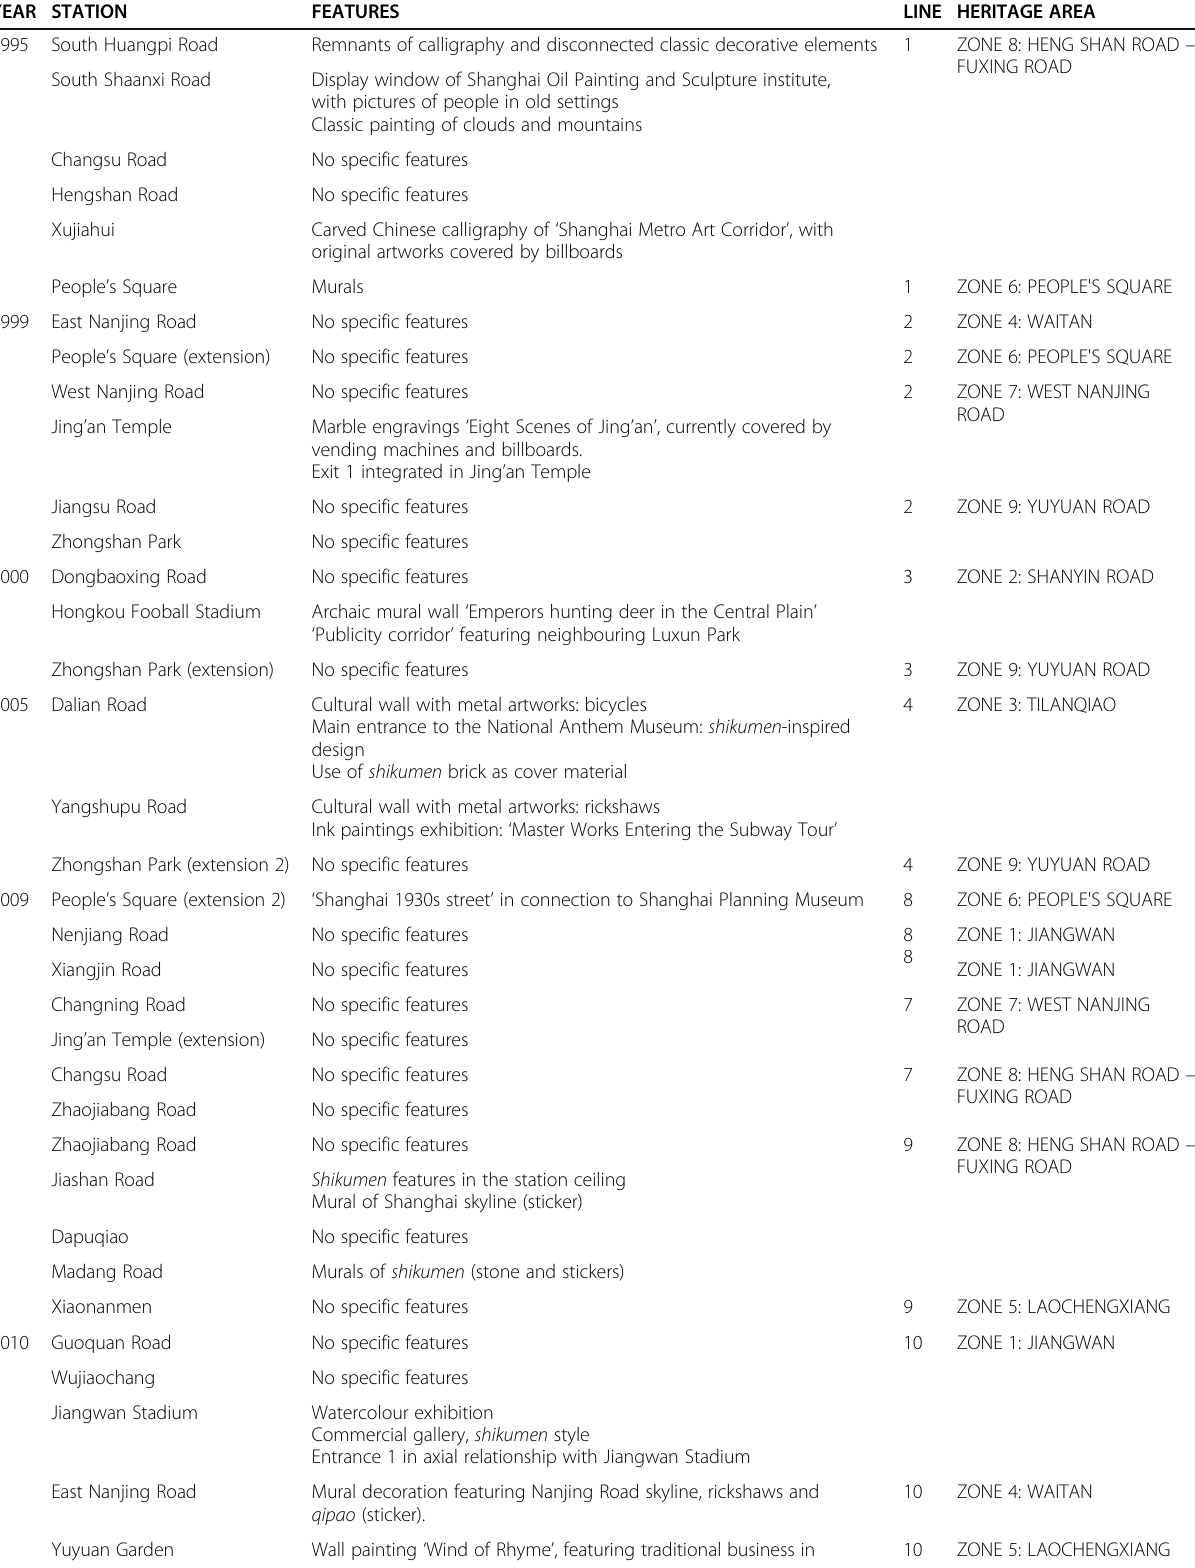
Table 2 Main cultural features incorporated to metro